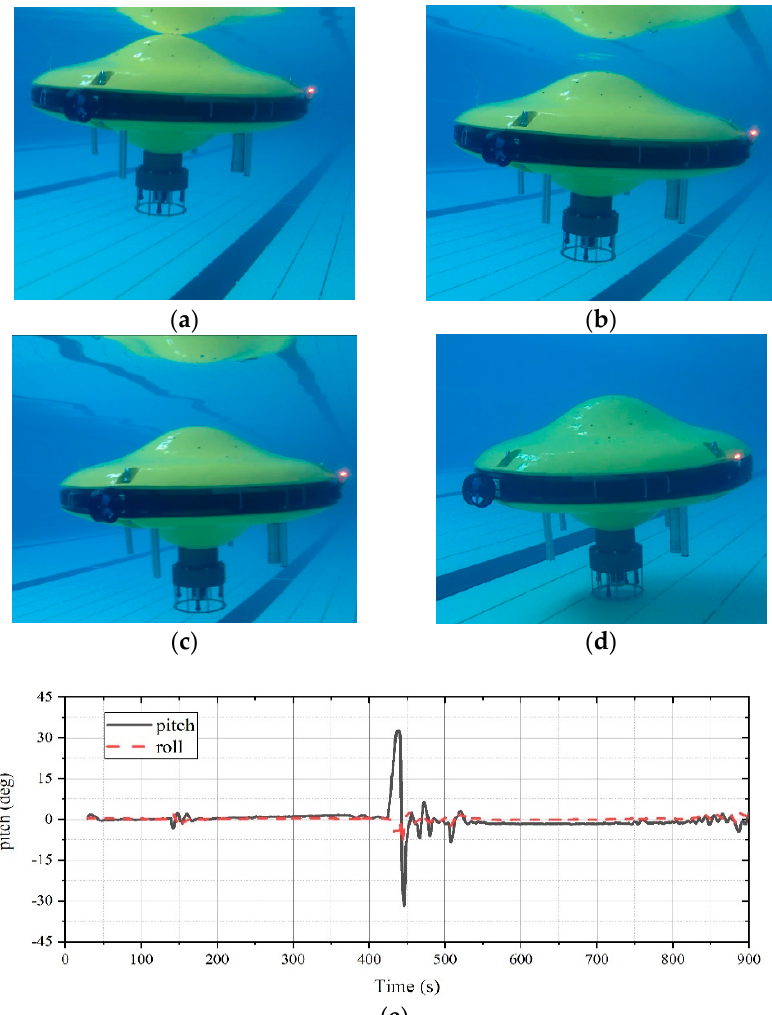
Figure 16. The vertical lifting motion and landing experiment. ( a ) AUH was near the surface of the water; ( b ) AUH began to sink; ( c ) AUH continued to sink; ( d ) AUH landed at the bottom of the pool; ( e ) the pitch angle and roll angle of AUH during the experiment.